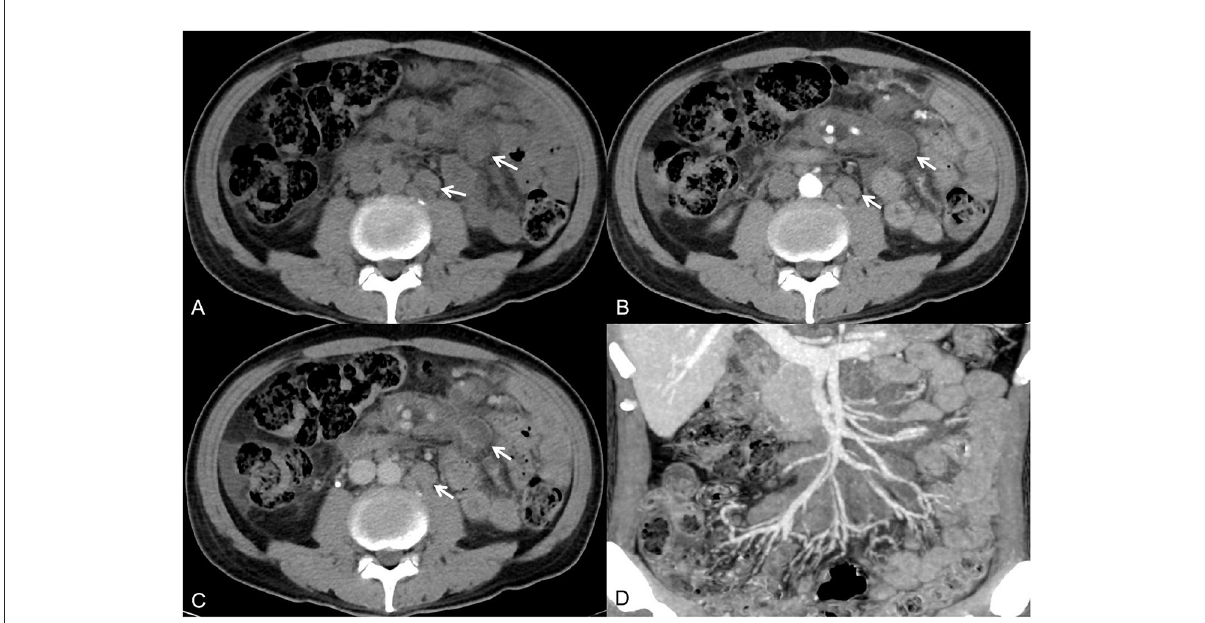
FIGURE1 A 54-year-old man had recurrent fever and malaise for 1 month. Axial non-contrast-enhanced CT imaging showed multiple enlarged lymph nodes in the mesentery and retroperitoneum [ (A) , white arrow]. Axial contrast-enhanced CT images showed lymph nodes with rim or homogeneous low enhancement [ (B,C) , white arrow]. The maximum intensity projection image showed that the surrounding blood vessels were not invaded (D) .